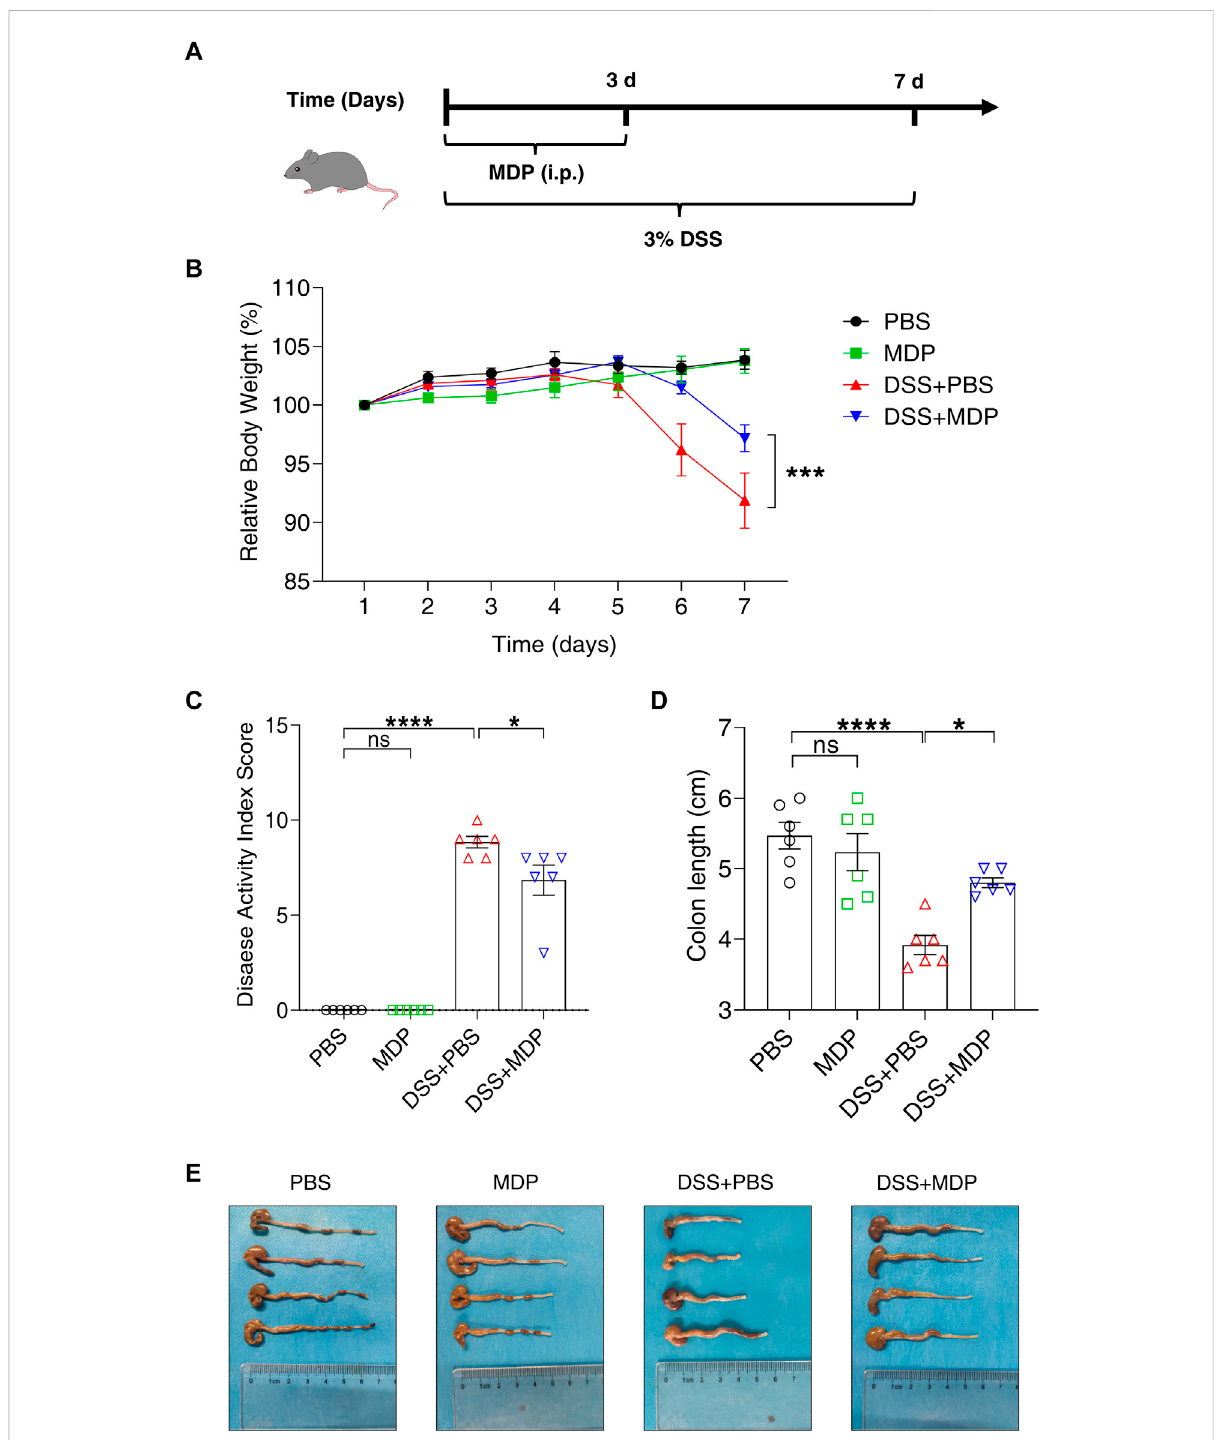
FIGURE 1 MDP alleviates DSS-induced intestinal injury in C57BL/6 mice. (A) Experimental timeline was shown. C57BL/6 mice were divided into four groups: PBS group, MDP group, DSS + PBS group, and DSS + MDP group (n = 6, each group). Each group received continuous intraperitoneal injections(i.p.)ofMDP(100 μ g)orsterilePBS100 μ LfromDay1toDay3,respectively.Themicedrankwateror3%DSSfromDay1toDay7. (B) Body weight of mice was recorded every day. (C) Weight loss, stool consistency, and blood of mice were observed for evaluating disease activity index scores. (D,E) Mice were euthanized on Day 8. The colon was taken and the length was measured and photographed. Data were expressed as mean ± SEM. * p < 0.05, *** p < 0.001, **** p < 0.0001, ns, not signi fi cant, One-way or Two-way